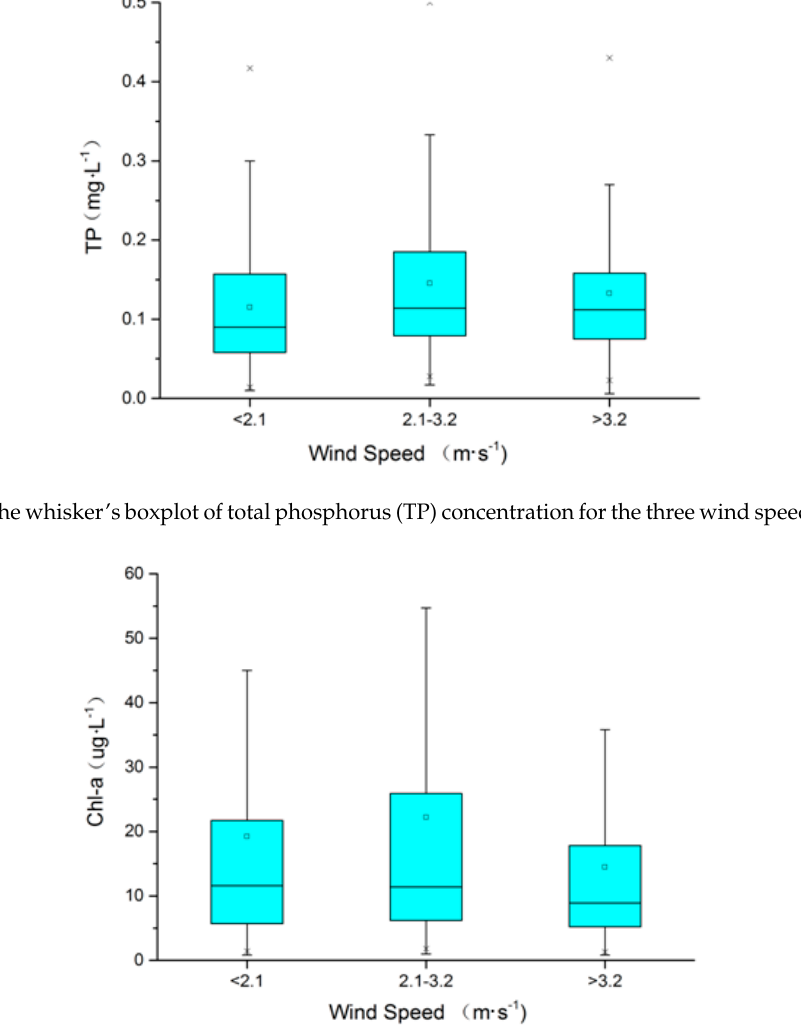
Figure 10. The whisker’s boxplot of chlorophyll-a (Chl-a) concentration for the three wind speed groups.